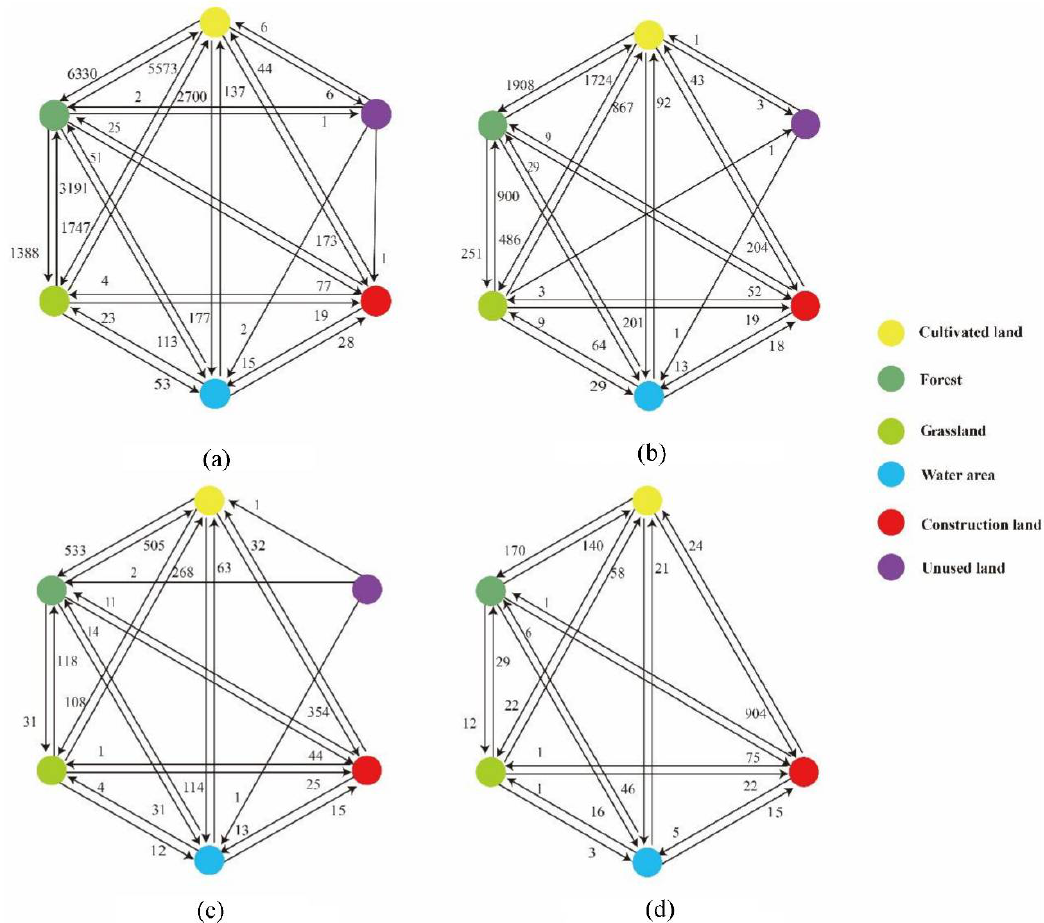
Figure 11. Complex network model of land-use changes in different regions: ( a ) significant increase, ( b ) non-significant increase, ( c ) non-significant decrease, and ( d ) significant decrease.